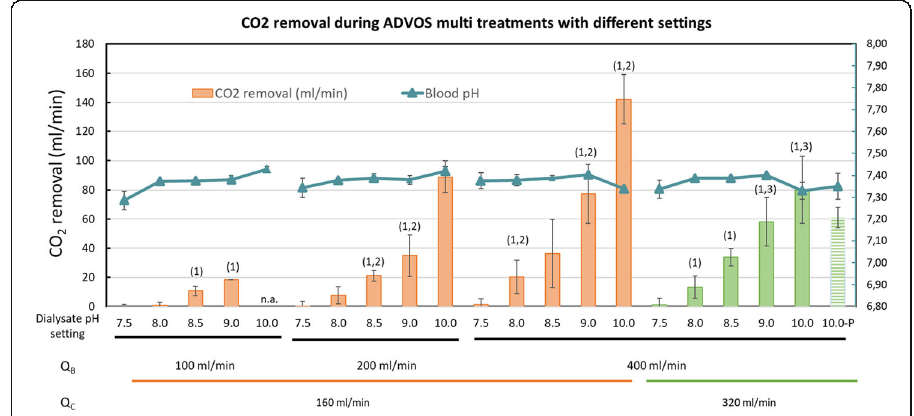
Fig 2 Results from blood gas analysis obtained after hemodialysis of swine blood under different treatment settings with ADVOS. Experiments with dialysate pH 10 were performed with the basic concentrate without Na 2 CO 3 (BC-Bic 0). The value “ 10-P ” corresponds to the experiments where CO 2 was supplied as long as physiological blood gas values were maintained (pH 7.35 – 7.45, pCO 2 35 – 45 mmHg, HCO 3 − 22 – 28 mmol/l) and not only blood pH. Mean ± SD.1, p < 0.05 for CO 2 removal between consecutive dialysate pH settings among the same blood flow; 2, p < 0.05 for CO 2 removal between consecutive blood flows among the same dialysate pH setting; 3, p < 0.05 for CO 2 removal between consecutive concentrate flows among the same blood flow and dialysate pH